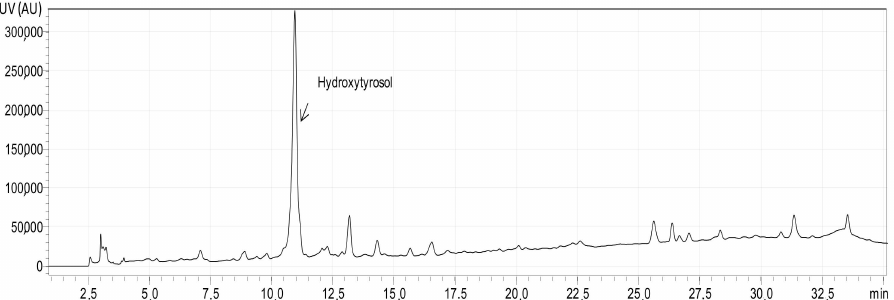
Figure 2. Chromatogram (280 nm) of the aqueous extract of exhausted olive pomace obtained using